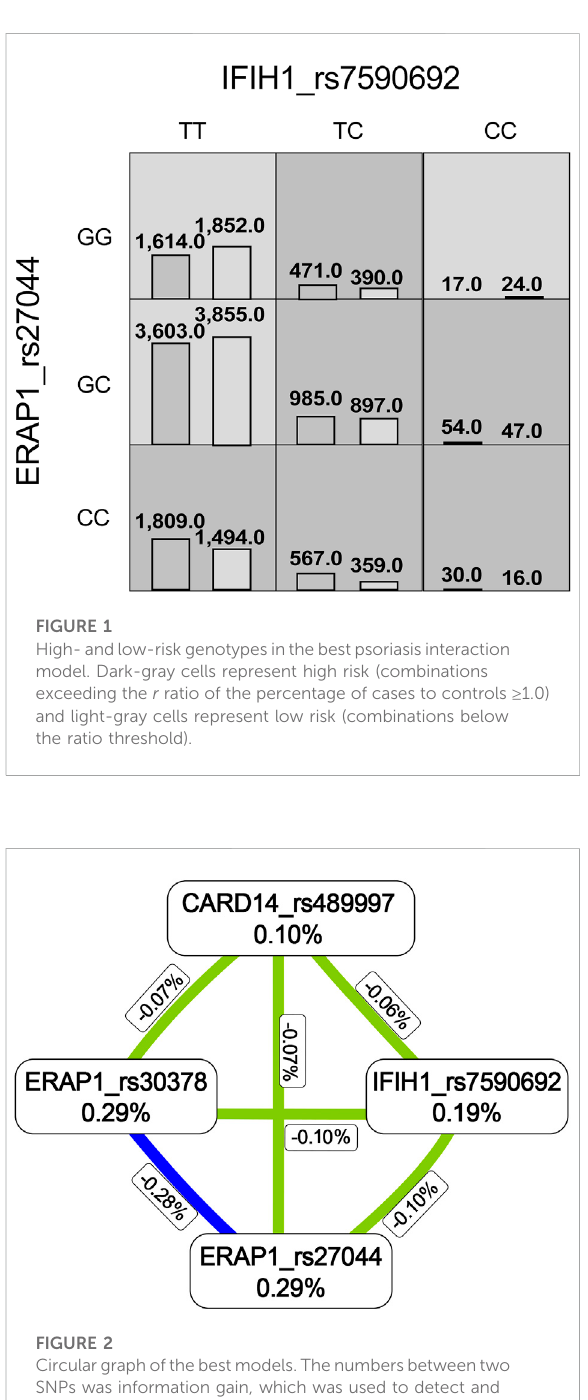
FIGURE 2 Circulargraphofthebestmodels.Thenumbersbetweentwo SNPs was information gain, which was used to detect and characterize epistatics of the interaction model and calculated by constructing two attributes using the MDR function. Red: positive information gain (synergistic or non-additive effect); blue: negative information gain (redundancy or correlation); yellow: no information gain